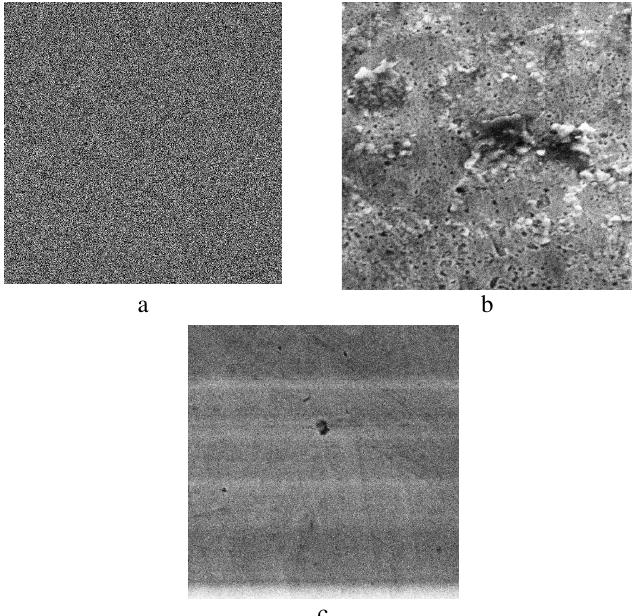
Figure 4. SEM of carbon steel: (a) steel polished; (b) steel immersed at 6 h in 0.5 M HCl; (c) steel immersed at 6 h in 0.5 M HCl + 0.5 x 10 -3 M